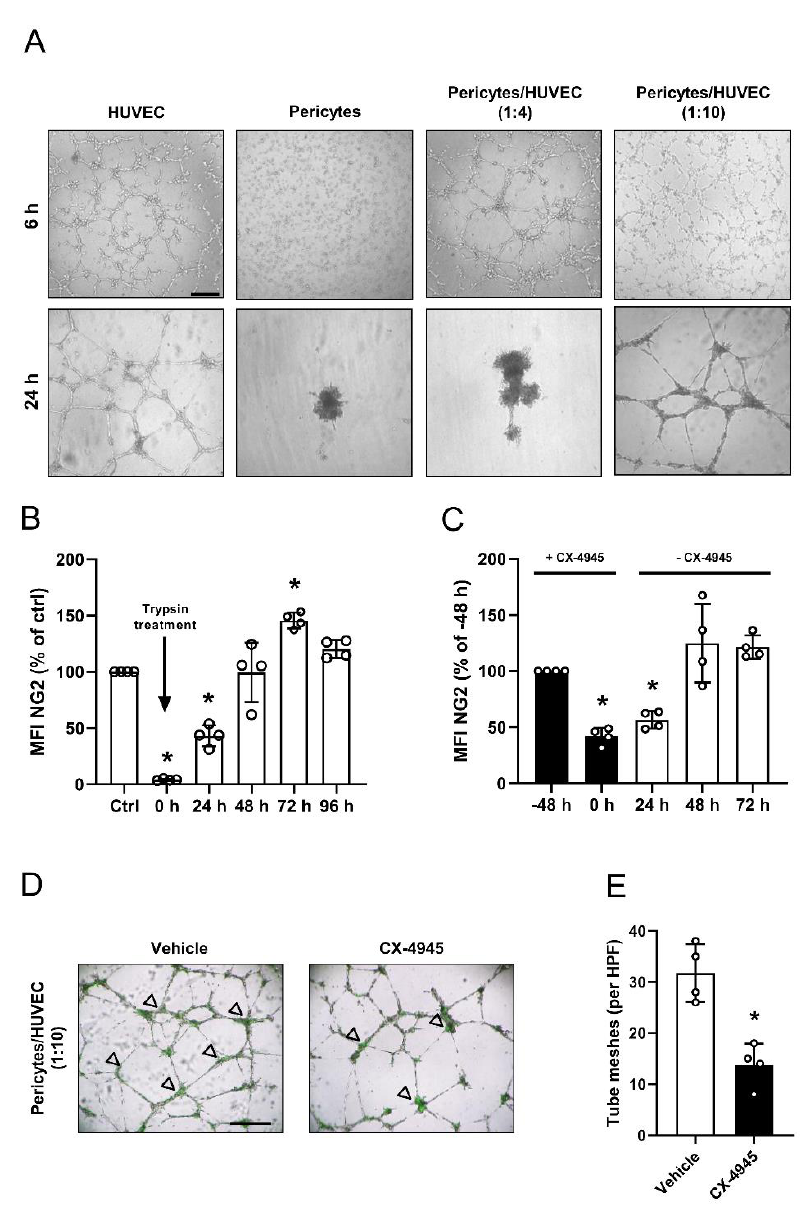
Figure 4. E ff ect of CK2 inhibition in pericytes on endothelial tube stabilization. ( A ) Tube formation assays were performed with HUVEC, pericytes as well as co-cultivated pericytes and HUVEC (ratio: 1:4 and 1:10). The formation of vessel-like structures was analyzed 6 and 24 h after seeding. Scale bar: 250 µ m. ( B ) Pericytes were trypsinized and NG2 protein levels were detected by flow cytometry at the indicated time points. NG2 protein levels of scratched pericytes was set 100%. Mean ± SD. * p < 0.05 versus ctrl ( n = 4). ( C ) Pericytes were treated with CX-4945 for 48 h (black bars) and subsequently incubated without CX-4945 (white bars) for the indicated time points. The NG2 protein levels were detected by flow cytometry. Pericytes at the time point -48 h were used as control and set 100%. Mean ± SD. * p < 0.05 versus -48 h ( n = 4). ( D and E ) Pericytes were treated with vehicle (DMSO) or CX-4945 (10 µ M) and cultivated for 48 h. Then, the pretreated pericytes were stained with a green fluorescence dye and co-cultivated with HUVEC (ratio: 1:10) ( D ). Arrows show green-stained pericytes at the branching points. Scale bar: 250 µ m. Quantitative analysis of the number of tube meshes (per HPF) after 24 h ( E ). Mean ± SD. * p < 0.05 versus vehicle ( n = 4).